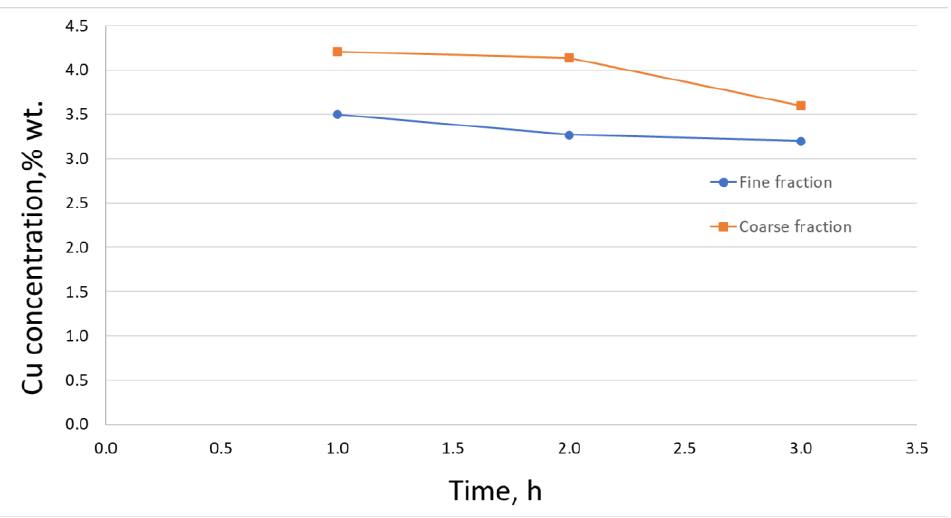
Figure 11. Copper content in the slag after the reduction process.